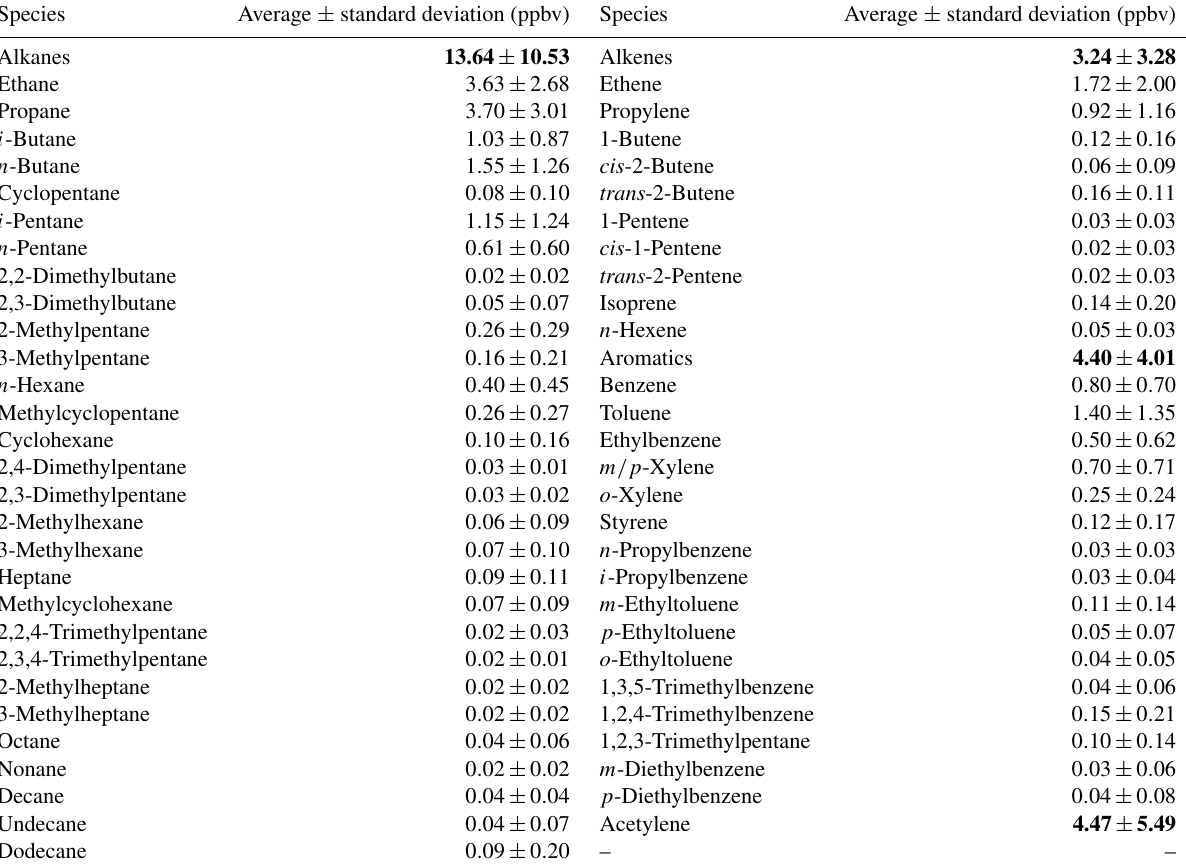
Table 1. The average mixing ratios and standard deviation of VOC species concentrations measured at the JAES site from January to December 2016. Values in bold font are the sum of mixing ratios of measured VOCs in each